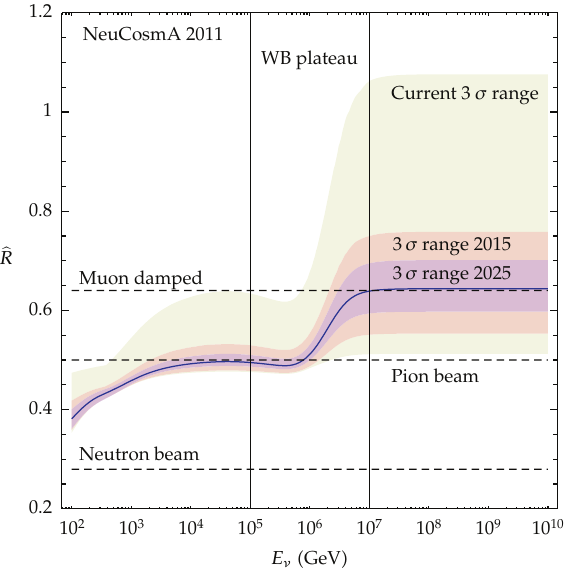
(cid:19) R Figure 7: Flavor ratio as a function of E ν at the detector for a GRB neutrino flux with the Waxman-Bahcall (cid:3) WB (cid:4) “plateau” (cid:3) in E 2 φ μ (cid:4) between 10 5 and 10 7 GeV (cid:3) cf. (cid:5) 17 (cid:6)(cid:4) . The shaded regions show the impact of the 3 σ mixing angle uncertainties now (cid:3) current (cid:4) (cid:5) 81 (cid:6) , in about 2015 (cid:3) next generation, dominated by Daya Bay and T2K (cid:5) 82 (cid:6)(cid:4) , and in about 2025 (cid:3) for a neutrino factory (cid:5) 83, 84 (cid:6)(cid:4) . Here θ 13 (cid:10) 0 is assumed for the sake of simplicity, figure taken from (cid:5) 30 (cid:6)